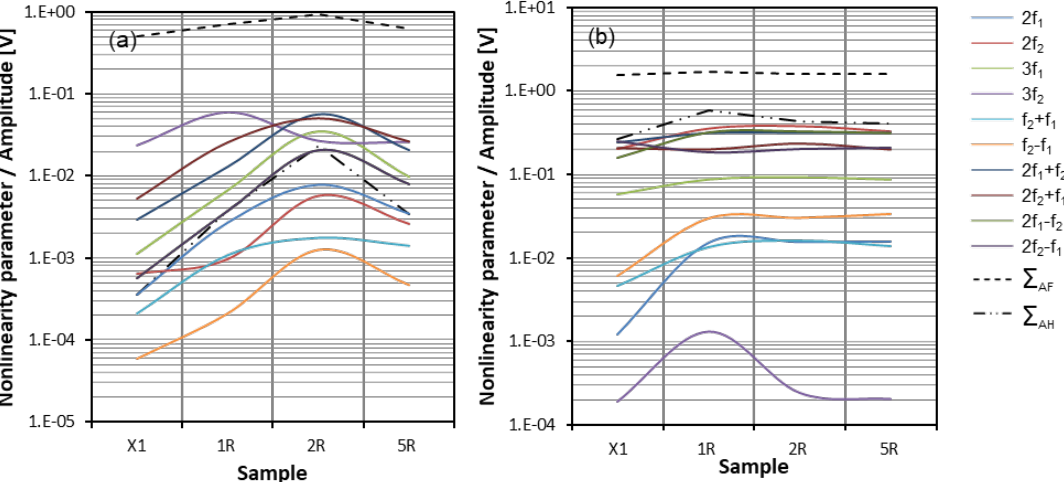
Figure 21. Nonlinearity parameter: ( a ) f 1 = 3 MHz, f 2 = 5 MHz, α = 90°; ( b ) f 1 = 4 MHz, f 2 = 5 MHz, α = 90°.